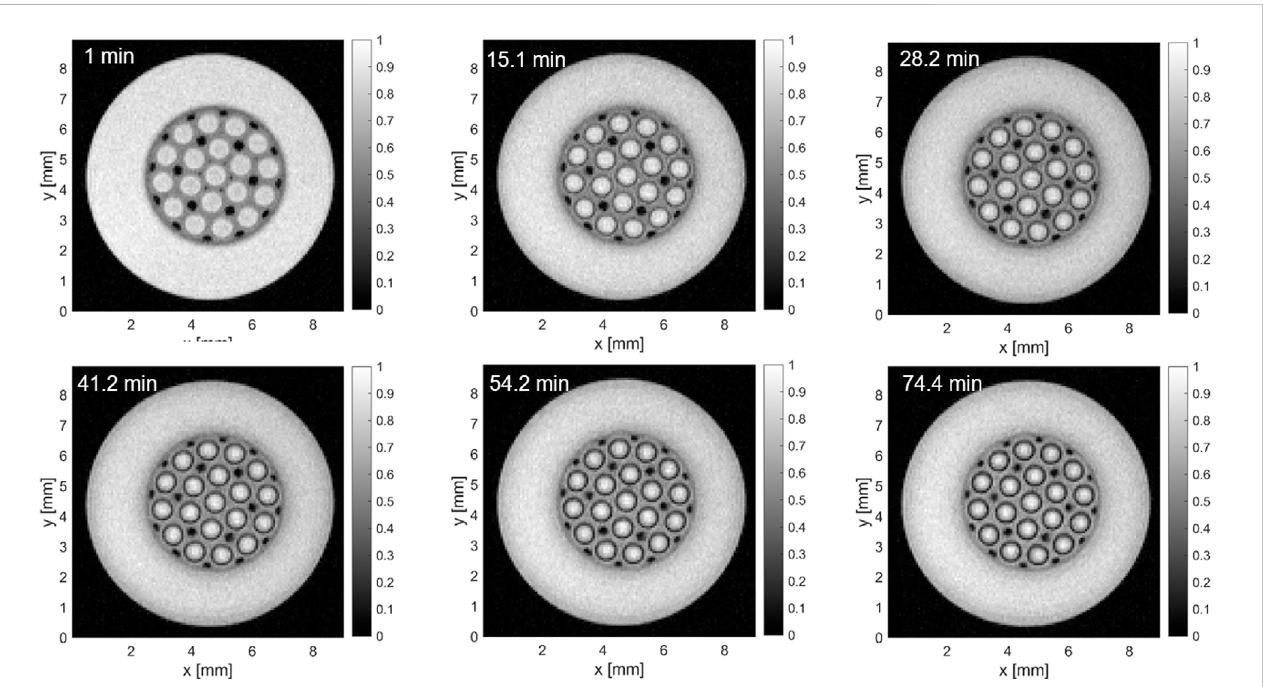
Exemplary axial MR images of a time series measured during fi ltration with aqueous sodium alginate at z = 32.5 cm. The fi ltration time is indicated in the images. The deposit forms on the inner surface of each of the channels, while the permeate keeps the expected high relative signal intensities. The deposit is already evident in the second image in the upper row after 15.1 min and has an effective thickness of more than 140 µm. During this fi rst hour of deposit formationthechannelsshowsimilarbehaviorwhichisindicatedbytherelativethicknessandtherelativesignalintensityofthedepositalongthe fi ltration time. Please also note that the air- fi lled areas in the membrane (black areas) are MR-silent over the complete fi ltration